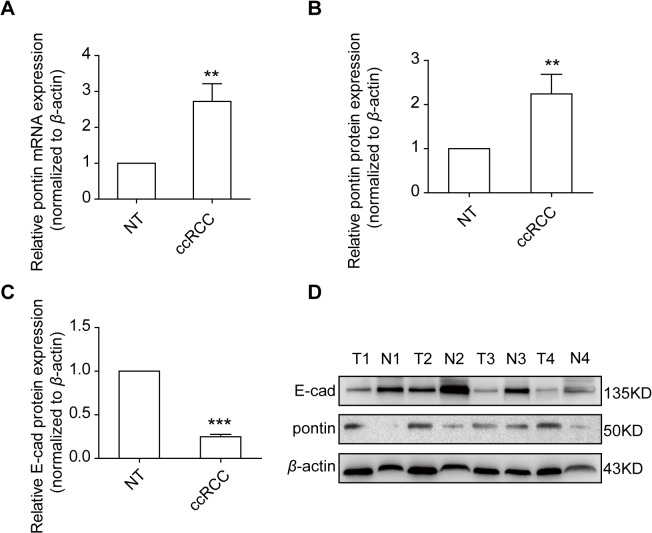
Pontin and E-cadherin expression profiles in 28 pairs of ccRCC tissues and the matched normal renal tissues.(A) Relative pontin mRNA levels determined by qRT-PCR. (B and C) Relative pontin and E-cadherin protein levels determined by western blotting analyses. (D) Western blotting analyses from 4 representative pairs of matched ccRCC and normal renal tissues. β-actin was used as a loading control. **P<0.01, ***P<0.001.